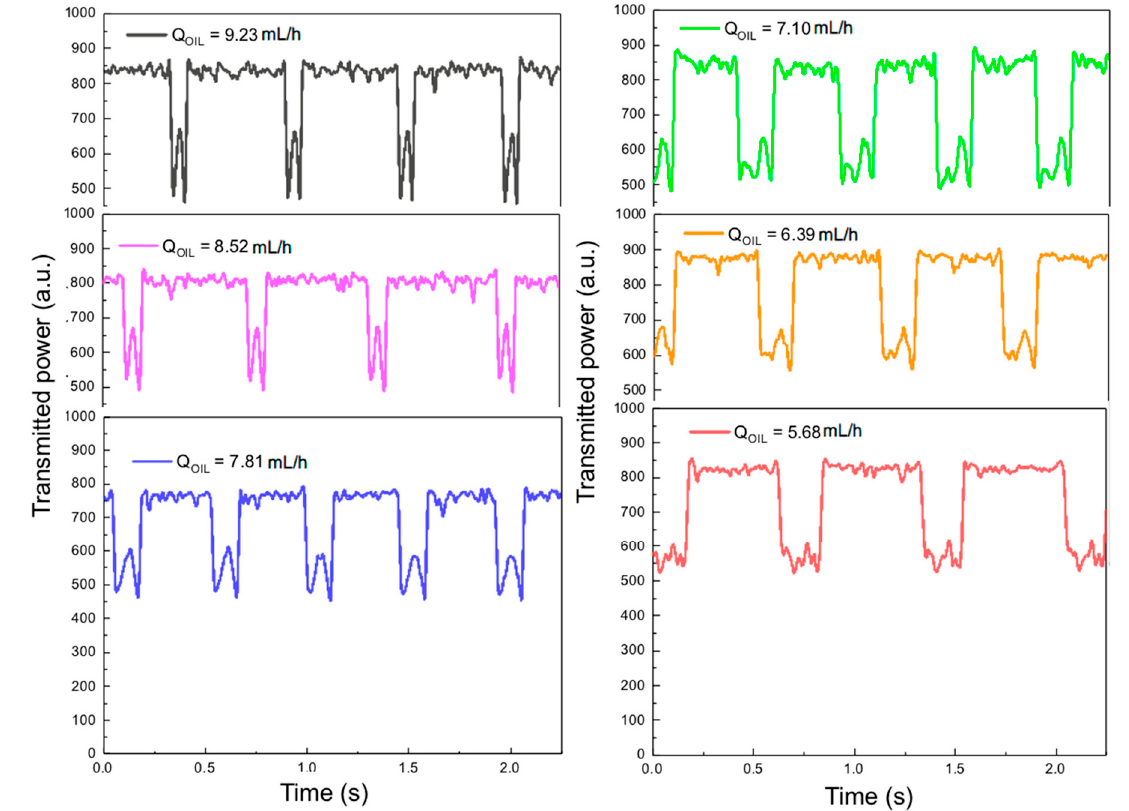
Figure 2. Transmittance curves obtained experimentally as a function of time for different flow